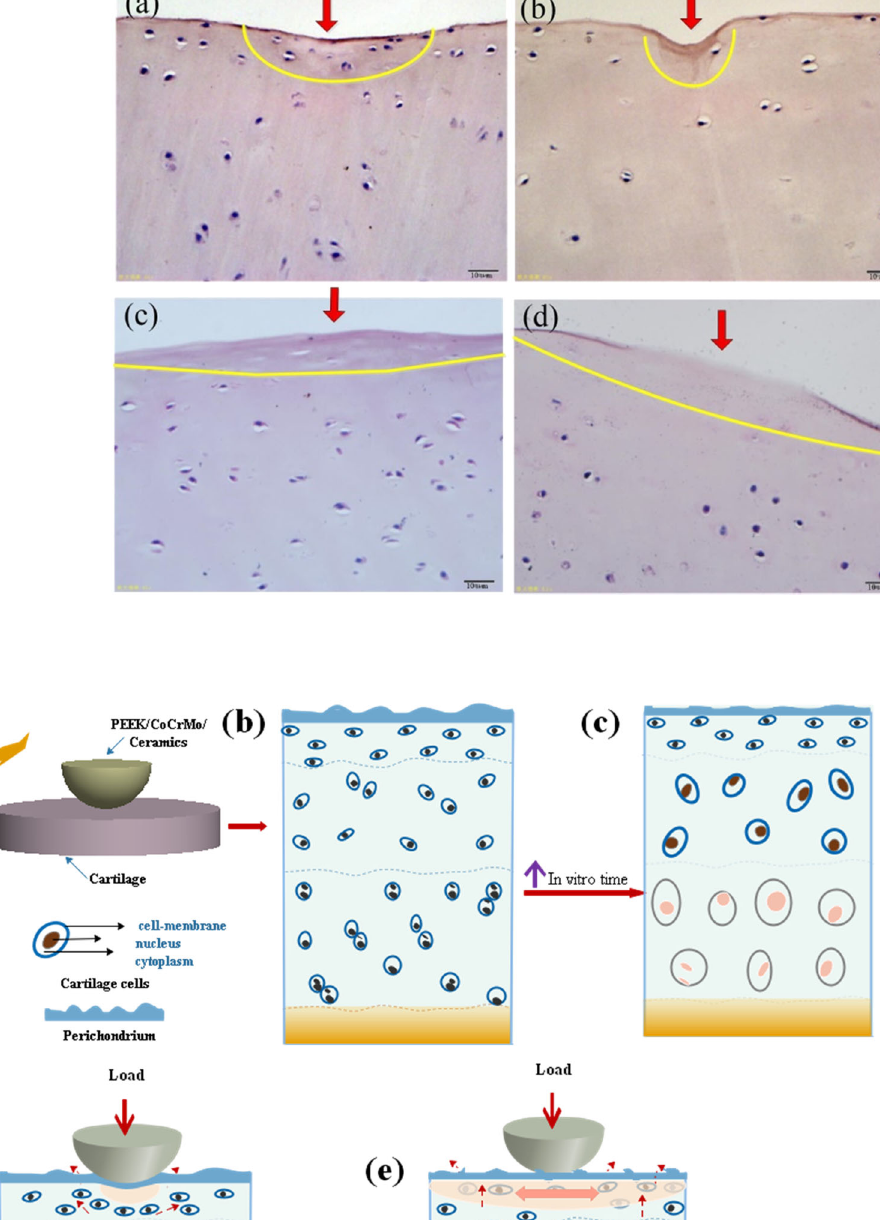
Fig. 13 The HE staining of PEEK/cartilage with different friction times. a 1 h; b 2 h; c 6 h;